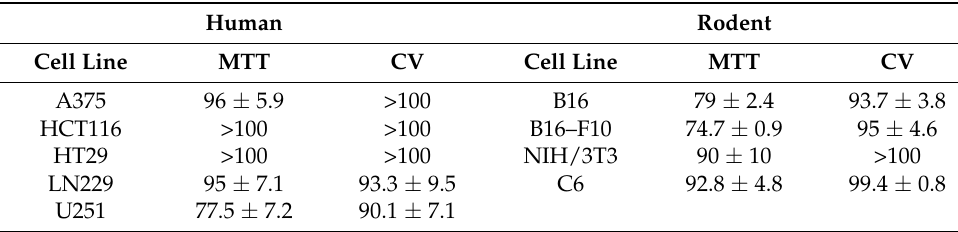
µ M. A375: human melanoma cancer cell line expressing COX-1 and COX-2 [47]. HCT116: human colon cancer cell line expressing COX-1 but not COX-2 [48]. HT29: human colon cancer cell line expressing COX-1 and COX-2 [48]. LN229 and U251: human glioblastoma cell lines non-expressing COX-2 [49,50]. NIH/3T3: mouse fibroblast cell line with expression of COX-1 and low expression of COX-2 [51]. B16 and its metastatic clone, B16–F10, murine melanoma cell lines, expressing both COX-1 and COX-2 [52]. C6: rat glioma cell line expressing both COX-1 and COX-2